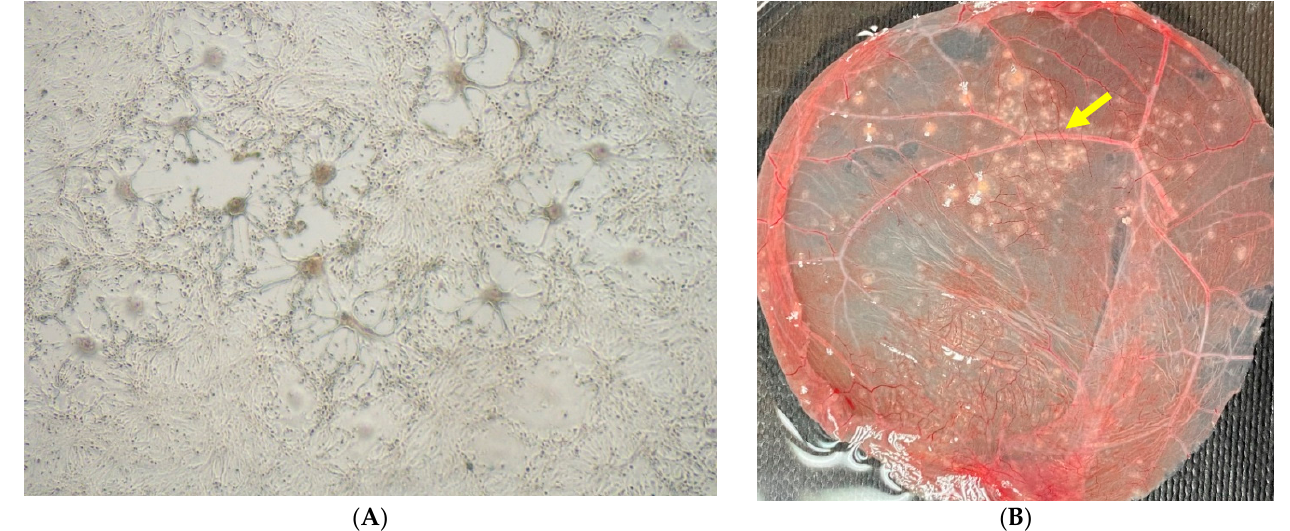
Figure 3 . ( A ) Typical camelpox plaque on Vero cells after 72 h of incubation at 37 °C, 40x magnification (D1621/20). ( B ) Characteristic camelpox lesions on the CAM of embryonated chicken eggs (yellow arrow), 5 days after incubation at 37 °C 10x magnification (D1621/20).